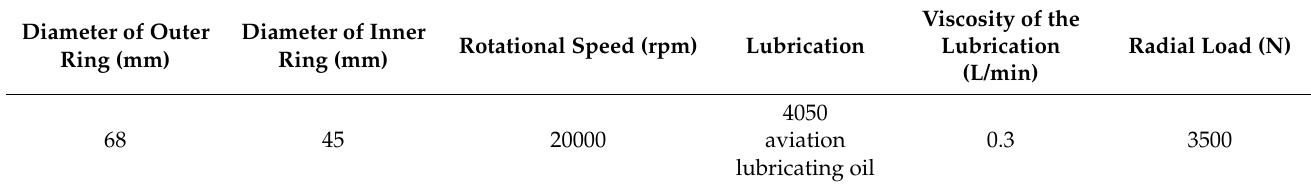
Table 1. Dimension and working conditions of the bearing .